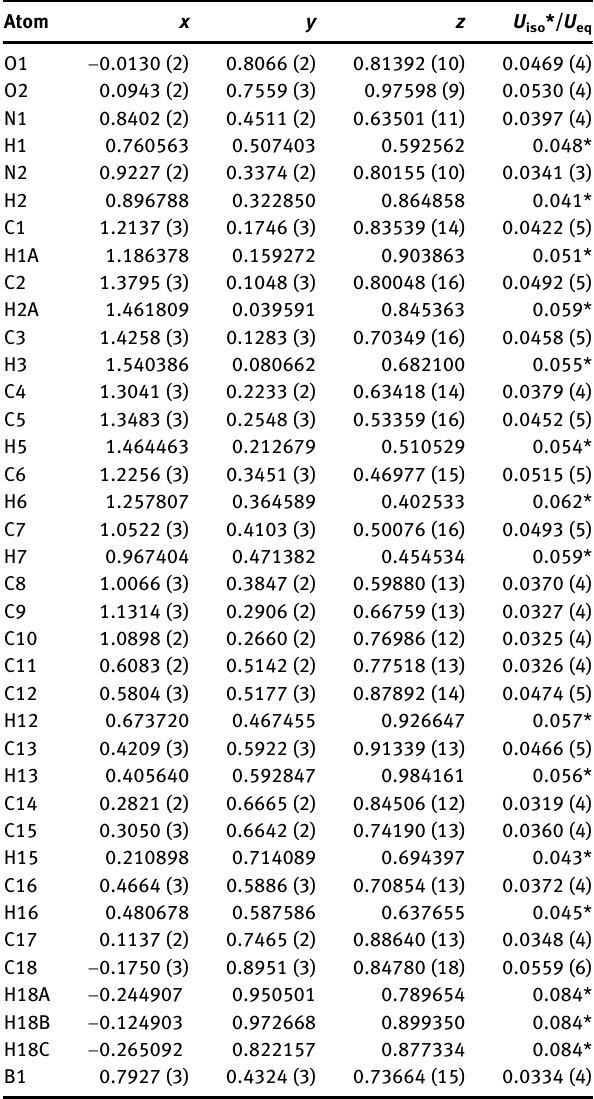
Table  : Fractional atomic coordinates and isotropic or equivalent isotropic displacement parameters (Å 